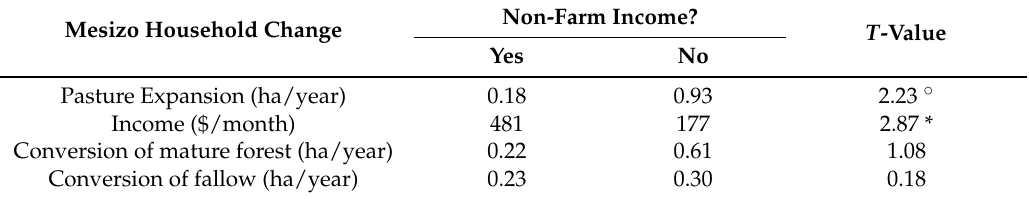
Table 4. T-tests on Mestizo household income (2005), rate of pasture expansion (2000–2006), and rates of deforestation (2000–2006) as determined by non-farm income held by at least one household member (2000), Bayano-Darién Region. Non-Farm Income? Mesizo Household Change T -Value Yes No Pasture Expansion (ha/year) 0.18 0.93 2.23 ˝ Income ($/month) 481 177 2.87 * Conversion of mature forest (ha/year) 0.22 0.61 1.08 Conversion of fallow (ha/year) 0.23 0.30